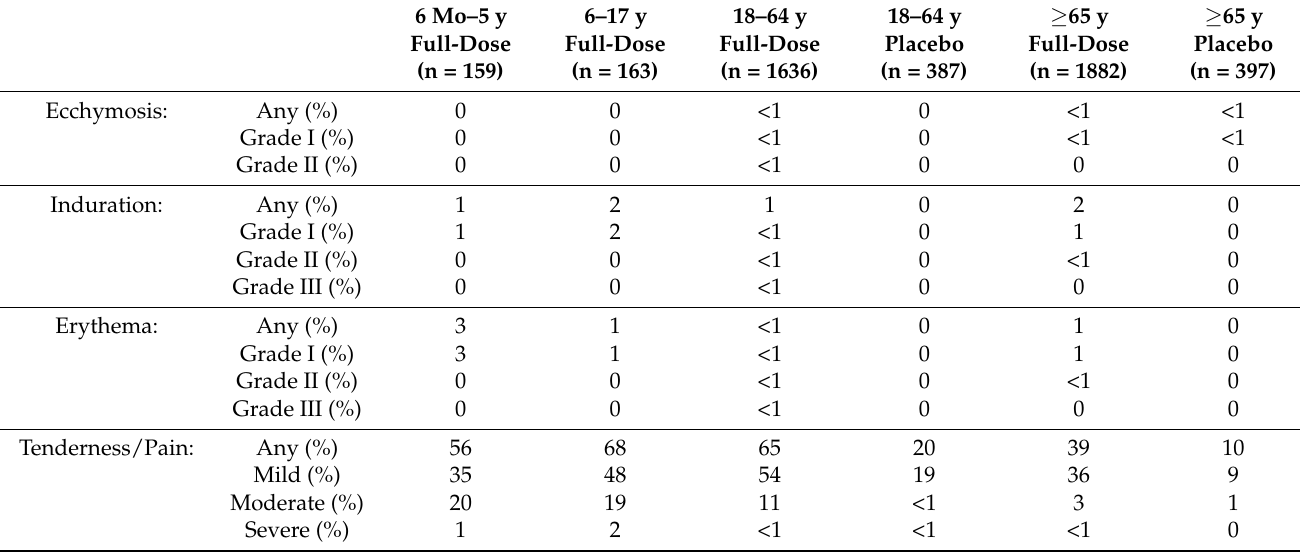
Table 5. Percentages of subjects experiencing solicited local adverse events within seven days of any vaccination.